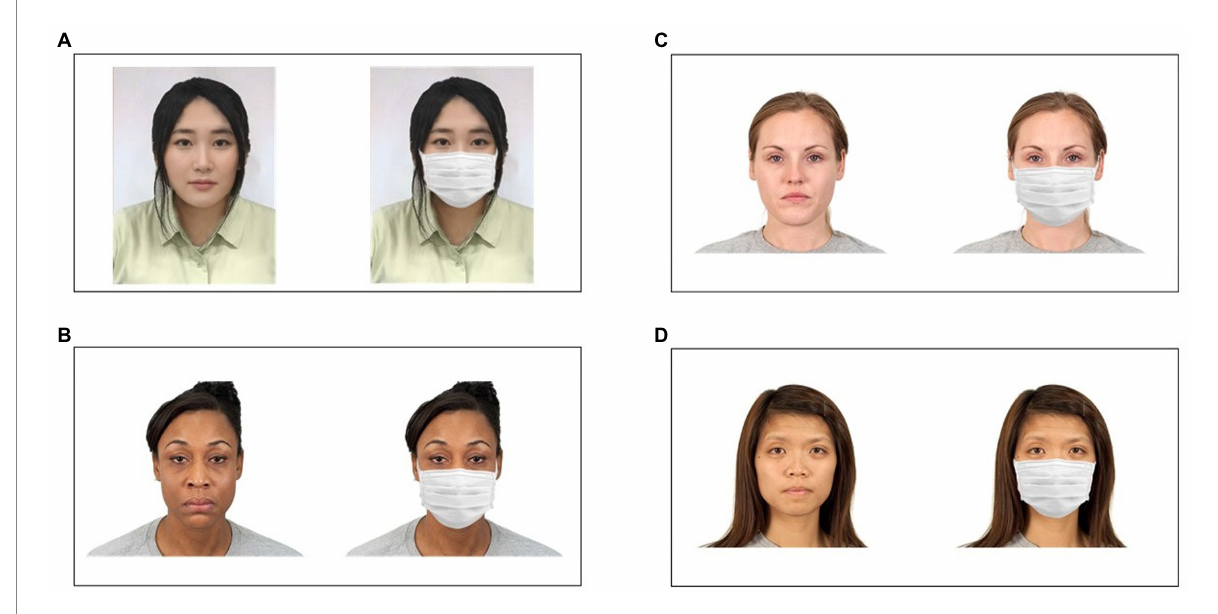
FIGURE 2 Examples of mask-free and masked faces. (A) Japanese females. (B) Black females. (C) White females. (D) Non-Japanese Asian females. The Japanese female faces (shown in panel A ) were not used in the present study. Black, White, and non-Japanese Asian female faces shown in panels B–D were used in the present study.